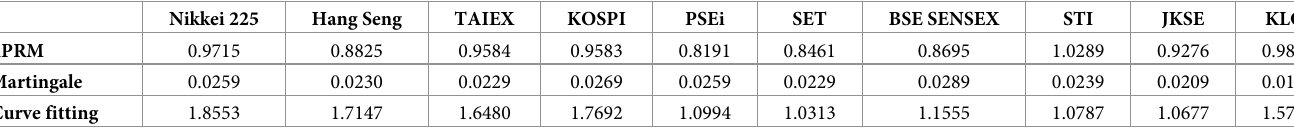
Table 6. Average computational time (unit: Second). Nikkei